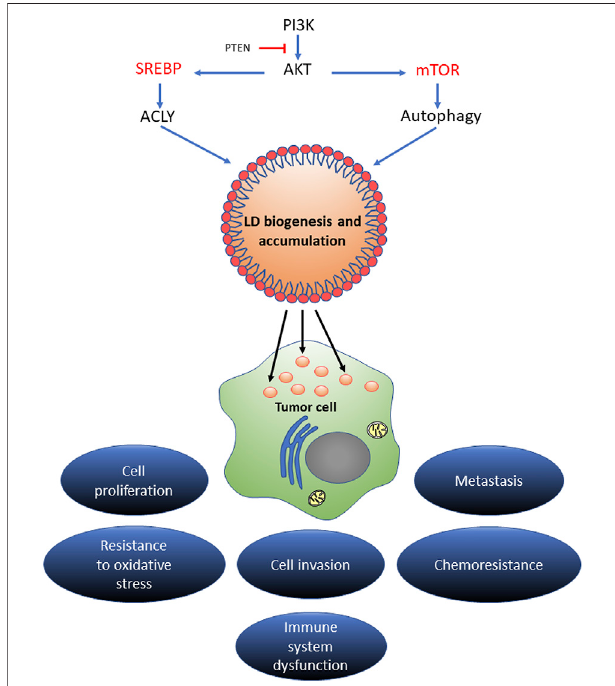
FIGURE 5 | The regulatory mechanism of LD in cancer progression. Different signaling pathways of lipid acquisition may drive LD biogenesis in stressed cancer cells. Increased LD contents could expand the source of lipid substrates and energy to meet the metabolic needs of proliferating cancer cells. In the tumor microenvironment, LD could act as an energy reservoir for an aggressive cancer to trigger metastatic cloning. LD accumulation extensively mediates proliferation, invasion, metastasis, and oxidative stress and chemotherapy resistance in multiple types of